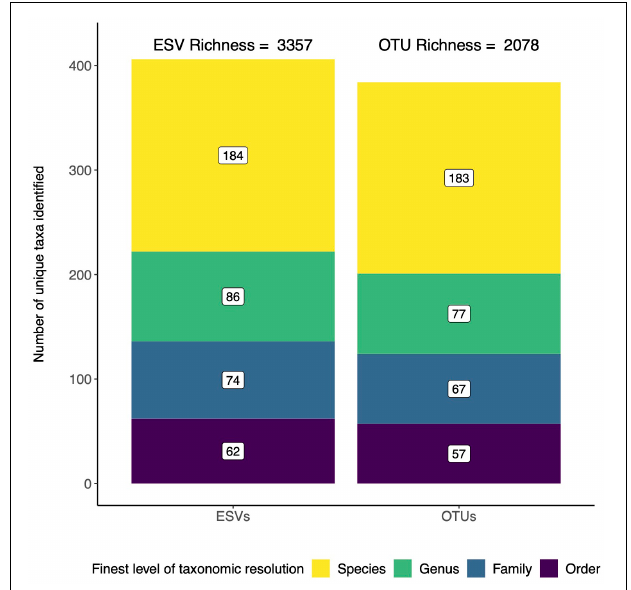
FIGURE 1 | ESVs detect more unique taxa than OTUs, but both reveal similar patterns in taxonomic resolution. Data is from a study that assessed arthropod diversity using COI metabarcoding of forest soil (Porter et al., 2019). The data was analyzed twice, first using denoised exact sequence variants (ESVs) and second using denoised ESVs that were clustered into operational taxonomic units (OTUs) based on 97% sequence similarity.